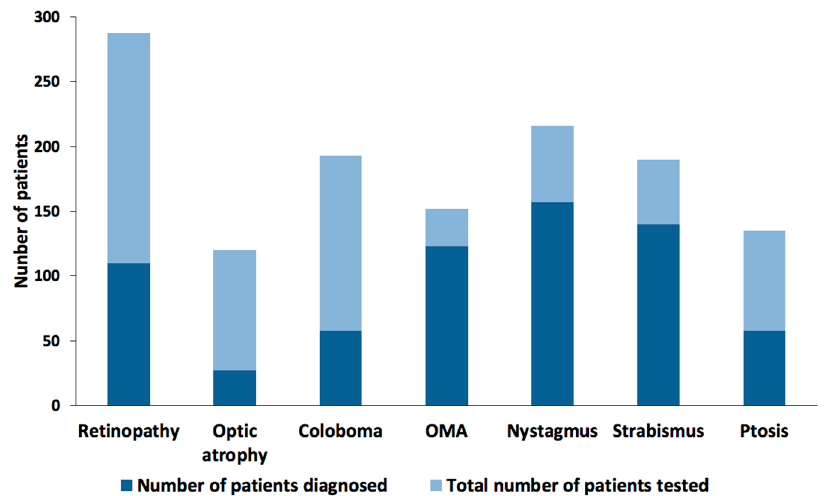
Figure 3. Frequency of phenotype observed based on the number of patients analyzed. OMA: Oculomotor Apraxia